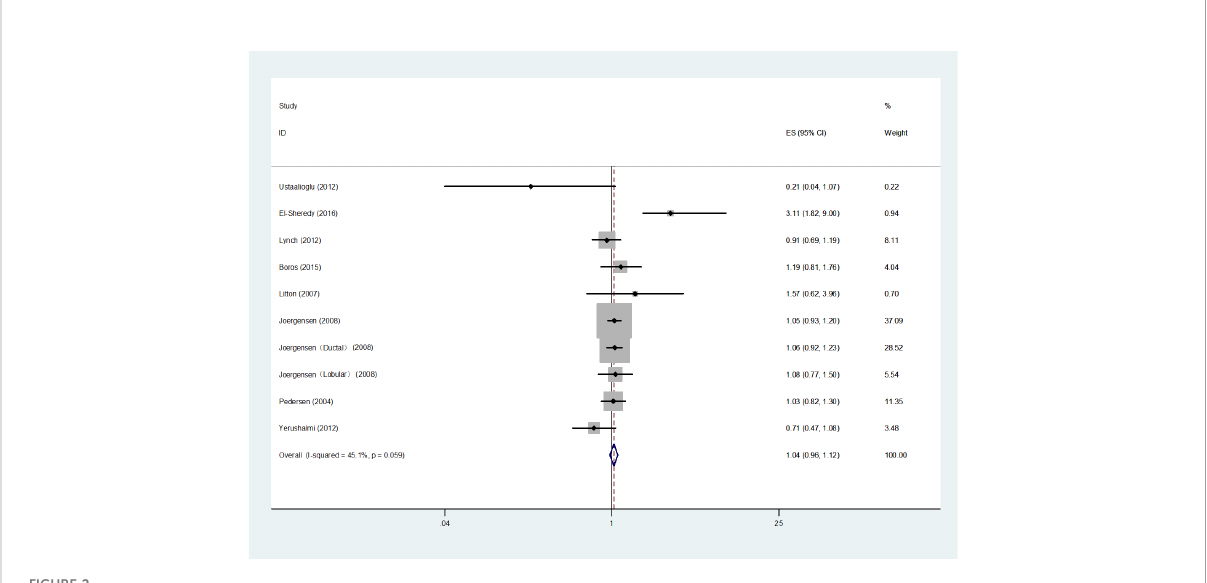
FIGURE 2 Forest plot of OS comparing MMBC and UFBC.